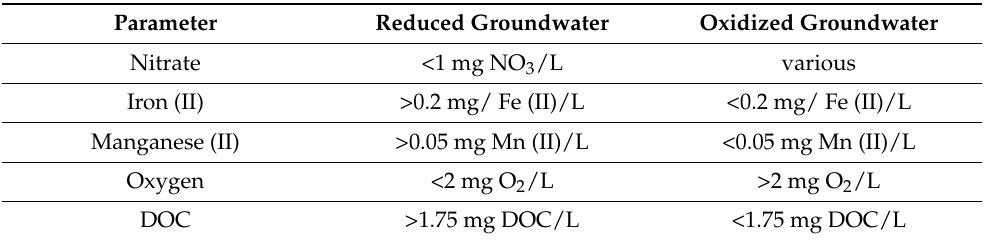
Table 2. Concentration ranges of essential redox parameters for identifying redox status and denitri- fication conditions in aquifers [10–13,26,31,39–48].